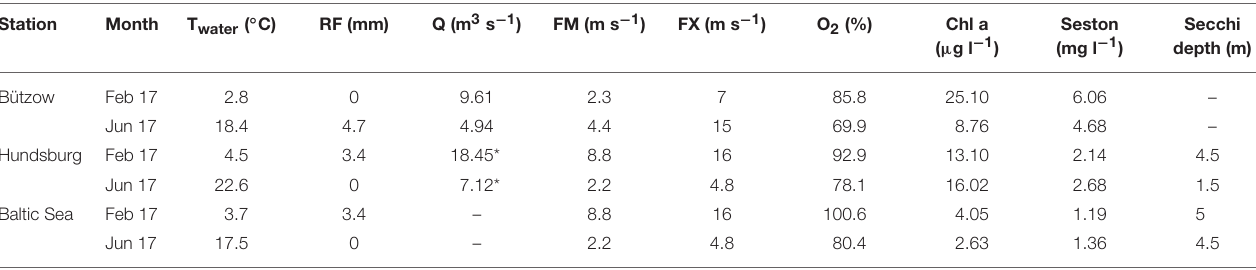
TABLE 4 | Abiotic and biotic parameter during sampling in February 2017 (Feb 17) and June 2017 (Jun 17) at the three stations of the study area; T water , water temperature in ◦ C; RF, rainfall as daily mean value in the area around the city of Rostock in mm; Q, discharge as daily mean value in m 3 s − 1 ; FM, mean wind velocity measured at the DWD-weather station in Rostock-Warnemünde in m s − 1 ; FX, maximum wind velocity measured at the DWD-weather station in Rostock-Warnemünde in m s − 1 ; O 2 , oxygen saturation in %; Chl a, chlorophyll a concentration in µ g l − 1 ; Seston, content of seston in mg l − 1 . Station